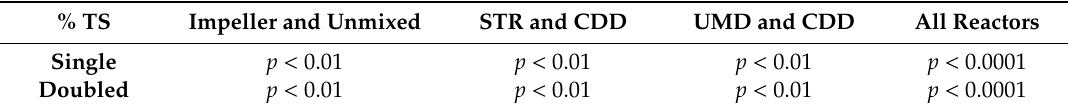
Table 6. Methane production at steady state for single and double influent total solids (TS) concentration. The data used are presented in Table 5. p = di ff erences in specific methane